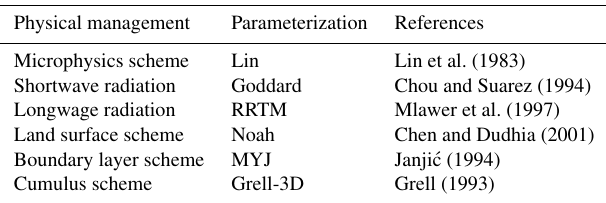
Table 2. Physical parameterization schemes used in the modeling study.